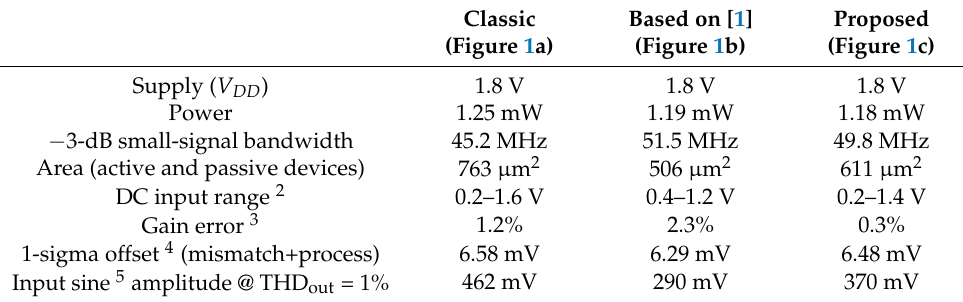
Table 2. Simulated buffer performance 1 using 180-nm CMOS process of ams AG Figure 6. Simulated offset induced by: ( a ) process corners (nominal and four corners: wz, wo, ws, wp); ( b ) mismatch (500 monte carlo runs).